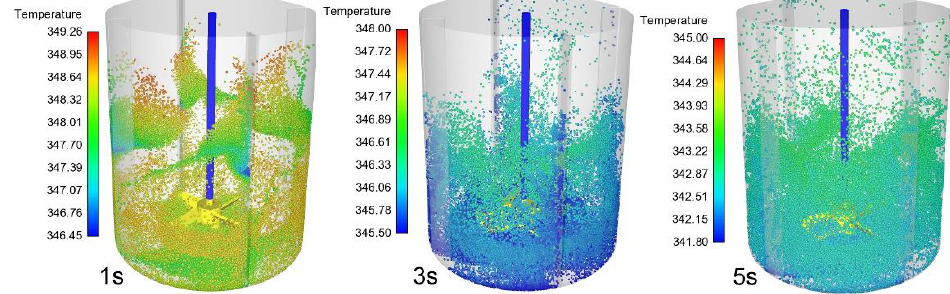
Figure 18. Schematic diagram of temperature and distribution of particles in stirred tank with baffles. Time is 1 s, 3 s, 5 s, respectively.